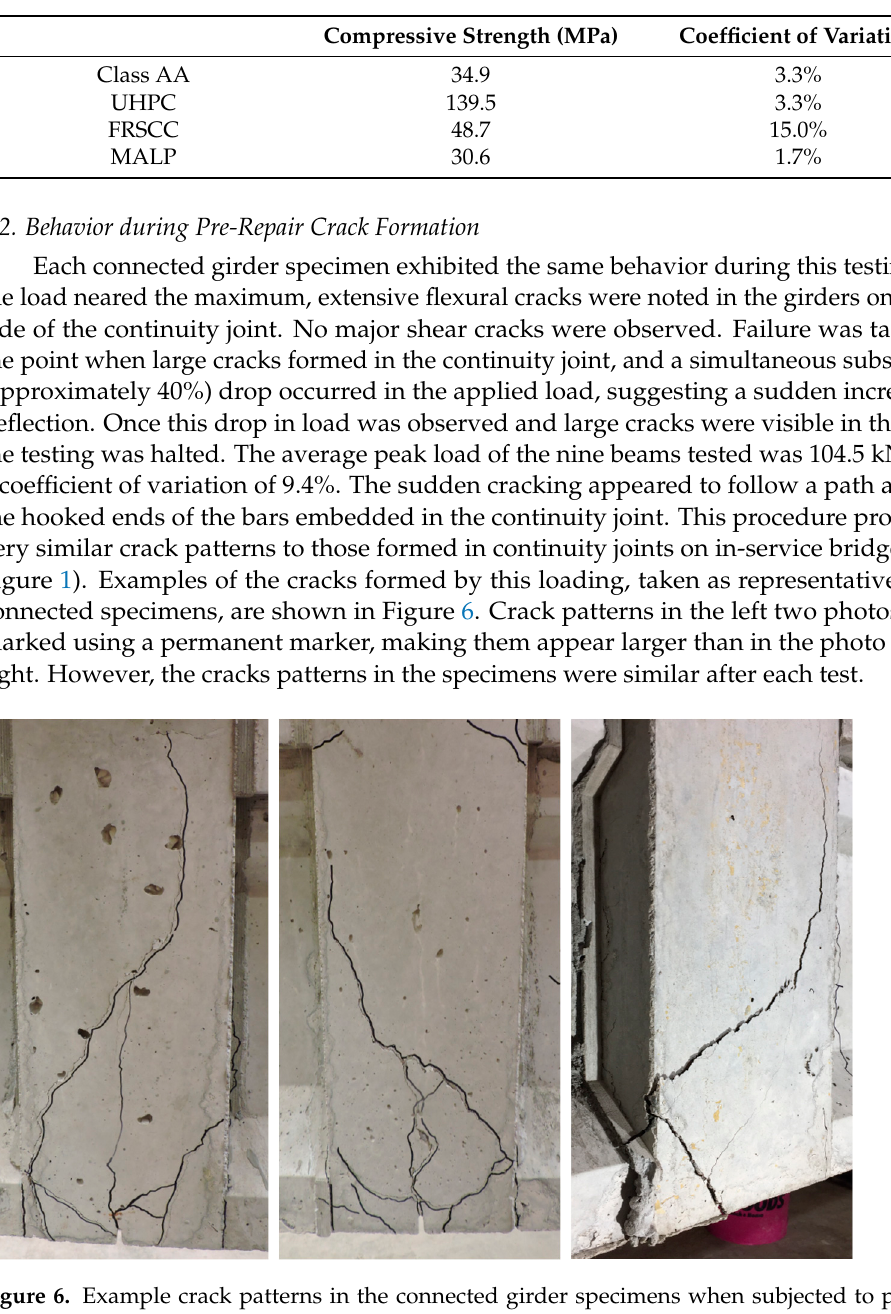
Table 2. Concrete compressive strengths at 28 days.